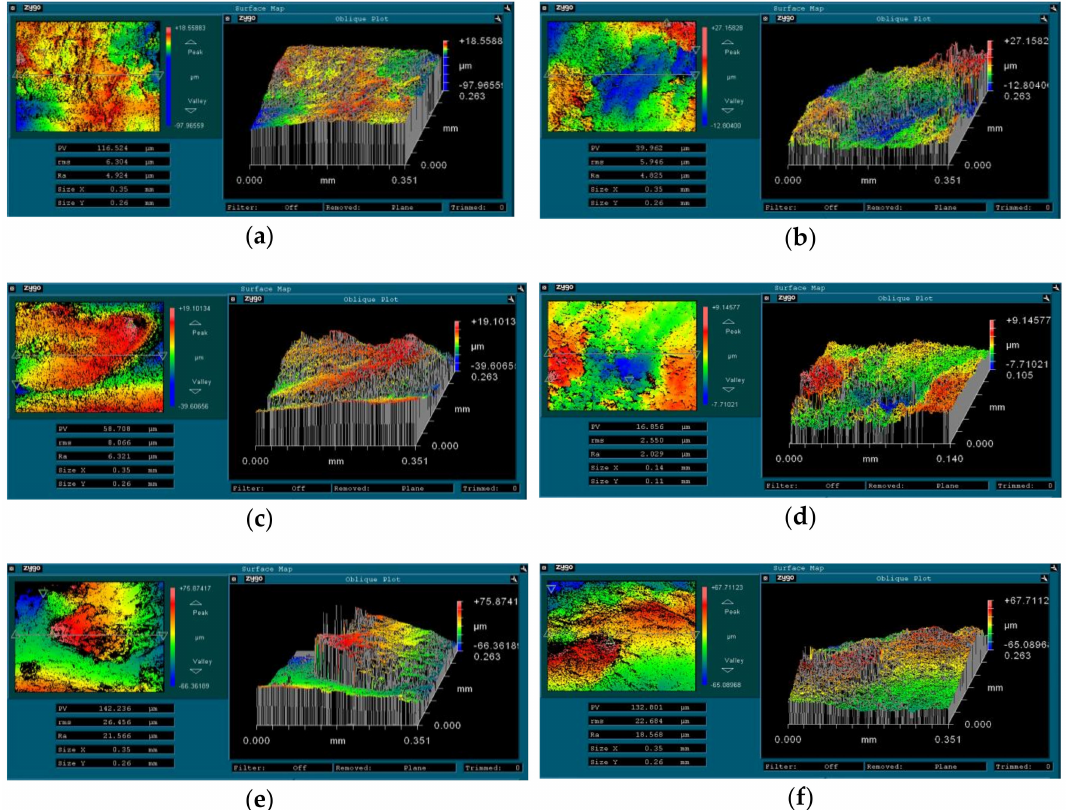
Figure 4. 3D-profilometry of the fracture surface of alloy VT23 under static deformation ( a , b ), DNP1 ( c , d ), and DNP2 ( e , f